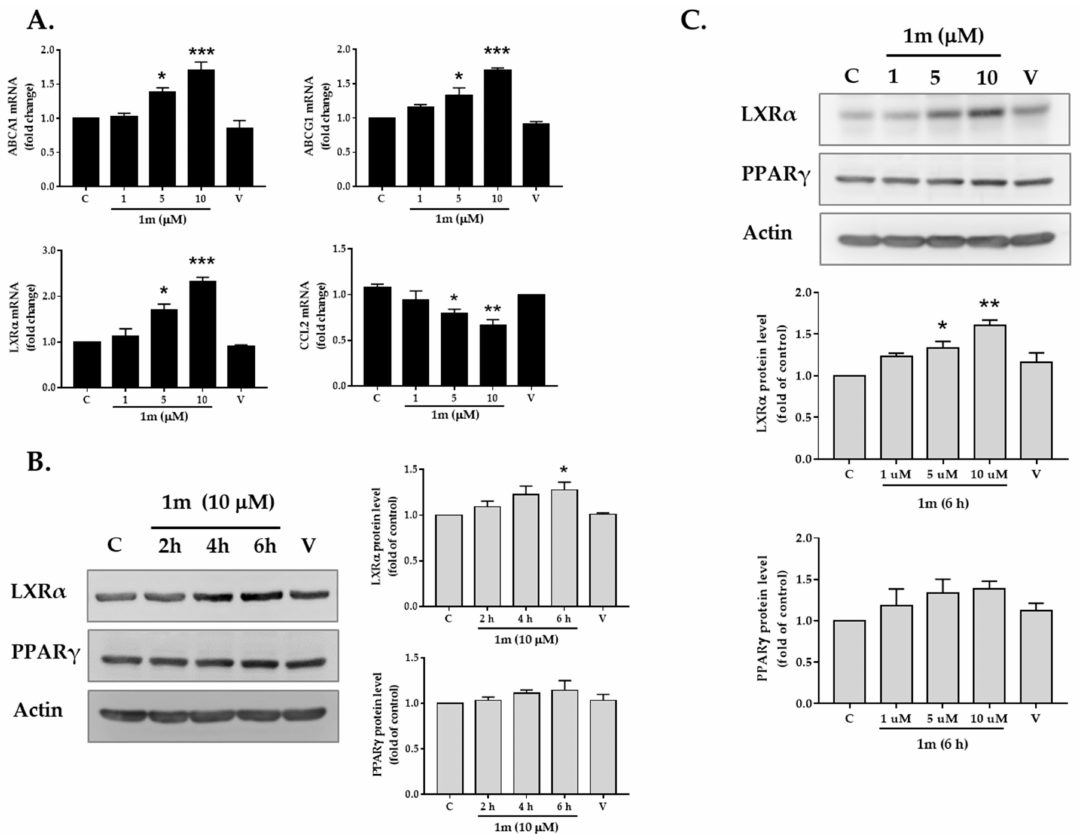
Figure 3. Protein and mRNA expression of transcriptional factor LXR α was enhanced in THP-1 macrophages treated with chalcone 1m . ( A ) THP-1 macrophages were treated with indicated concentrations (1, 5, and 10 µ M) of 1m for 24 h. Expression of mRNA of LXR α , ABCA1, ABCG1, and CCL2 was determined using qRT-PCR analysis. The relative expressions of mRNA are shown. ( B ) THP-1 macrophages were treated with 10 µ M of 1m for the time indicated (2, 4, and 6 h), or ( C ) treated with indicated doses (1, 5, and 10 µ M) for 6 h. Cell lysates were collected and protein expression of LXR α , PPAR γ , and Actin were determined by Western blot. Data are shown by representative bands and presented as the mean ± SEM of three independent experiments in triplicate after densitometric analysis. (* p < 0.05, ** p < 0.01, *** p < 0.001 vs.